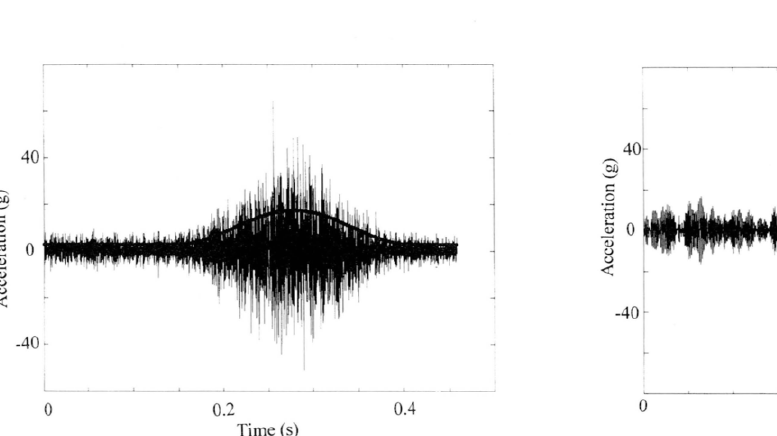
FIGURE 15 The response ofa 661-Hz SDOF system with 5% damping to a simulation of the event of Fig.